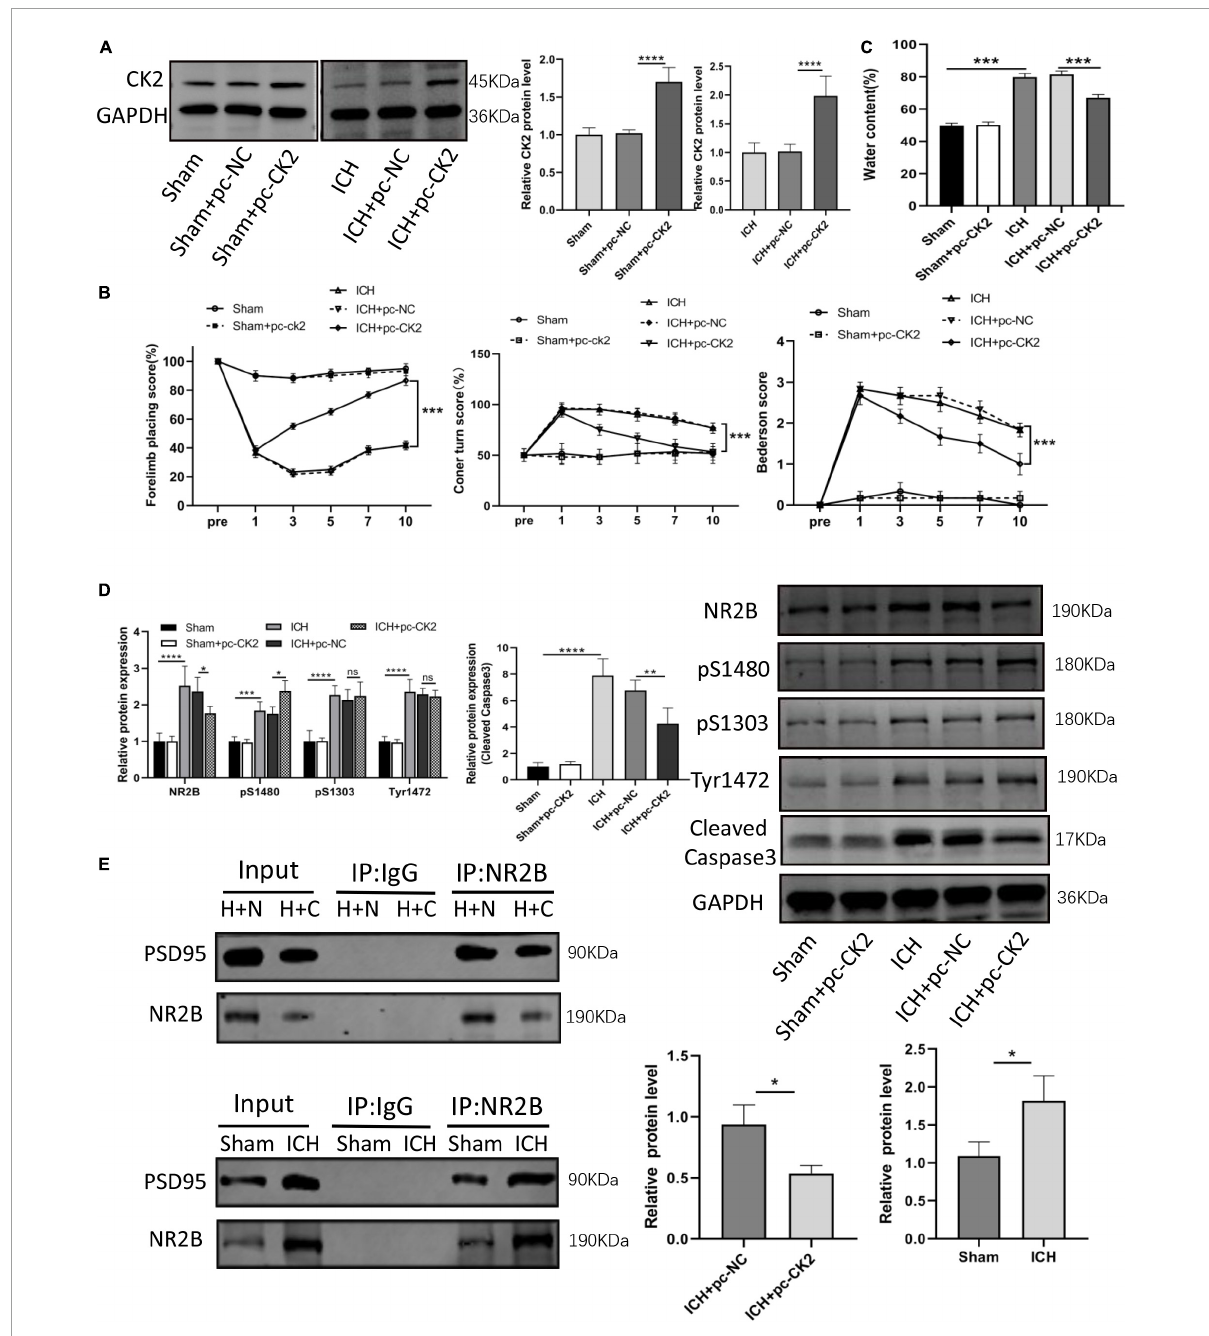
FIGURE3 Overexpression of CK2 alleviated brain injury in ICH rats. pcDNA-CK2 and pcDNA-NC were transfected into ICH rats. (A) Expression of CK2 was detected using Western blot ( n = 6). (B) Neurologic score was determined by the Forelimb placing test, corner turn test and Bederson score. (C) Analysis of brain edema. (D) Expression of cleaved caspase3, NR2B, NR2B phosphorylation sites S1480, S1303, and Tyr1472 were determined in rats using Western blot ( n = 6). (E) Representative gel images and quantification of co-immunoprecipitation (co-IP) show the level of NR2B-PSD95 complex in rat brain tissues ( n = 3). Data were expressed as mean ± standard deviation. * p < 0.05, ** p < 0.01, *** p < 0.001, **** p < 0.0001.